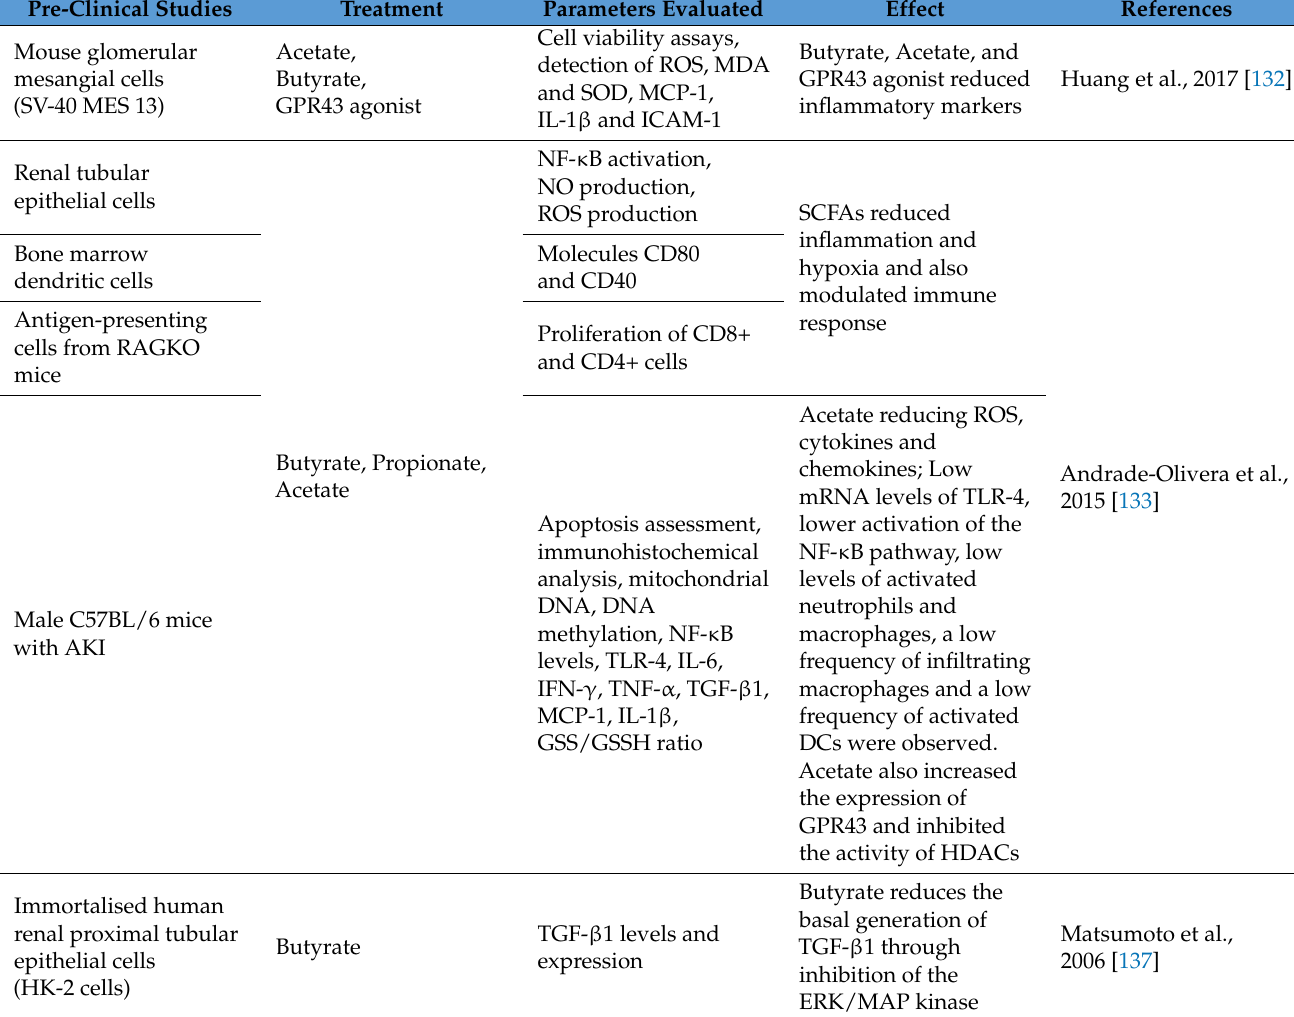
Table 2. Pre-clinical studies report a related improvement in SCFA levels both in in vitro and animal